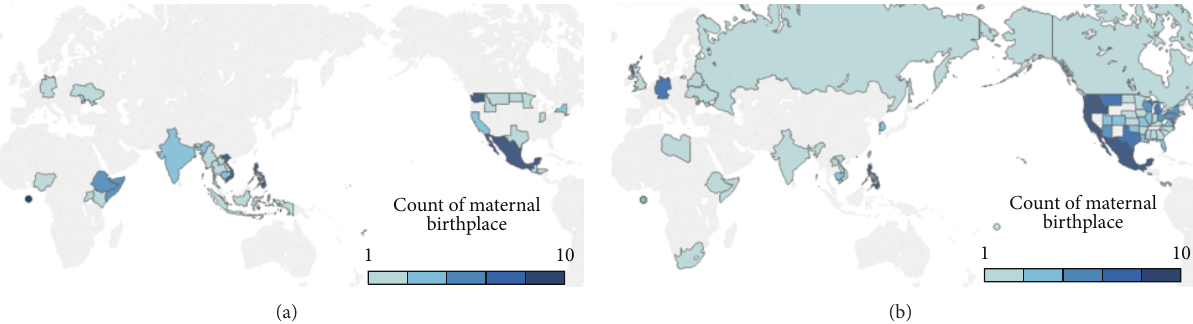
Figure 2: (a) Distribution of maternal birthplace for women with TB diagnosis. (b) Distribution of maternal birthplace for women without TB